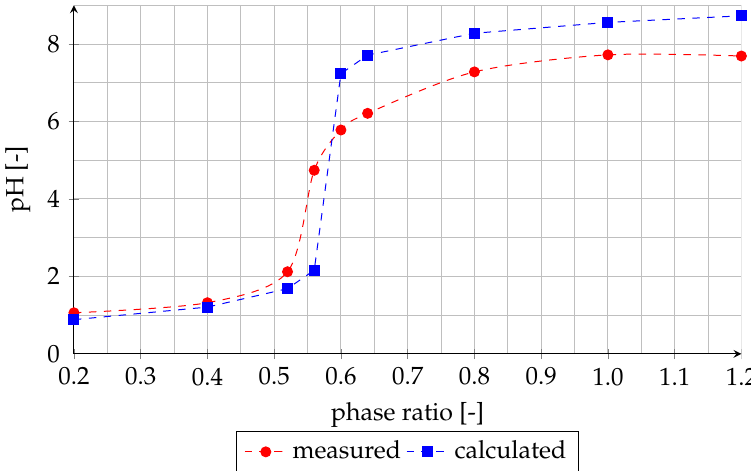
Figure 2. Effect of phase ratio on pH value of the aqueous phase after mixing of saponified organic phase with acidic water (experiment (1) ).